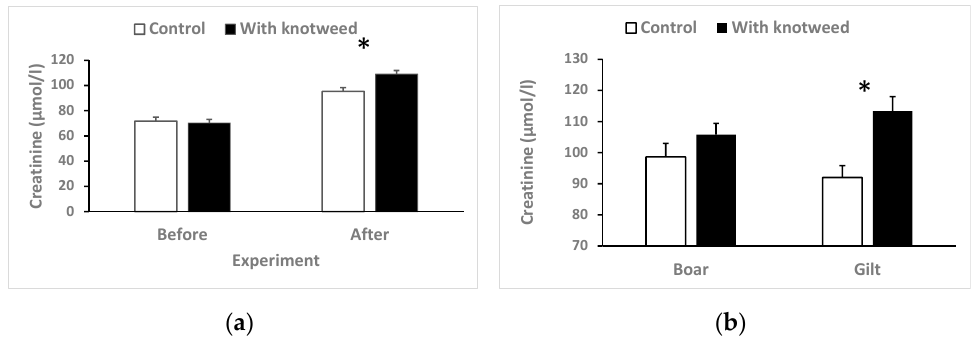
Figure 8. Serum creatinine in all animals at the beginning and the end of the experiment ( a ) and according to sex in the experimental group of pigs and the control group of pigs at the end of the experiment ( b ). Means + SEM. Difference significant on p < 0.05 marked by an asterisk.